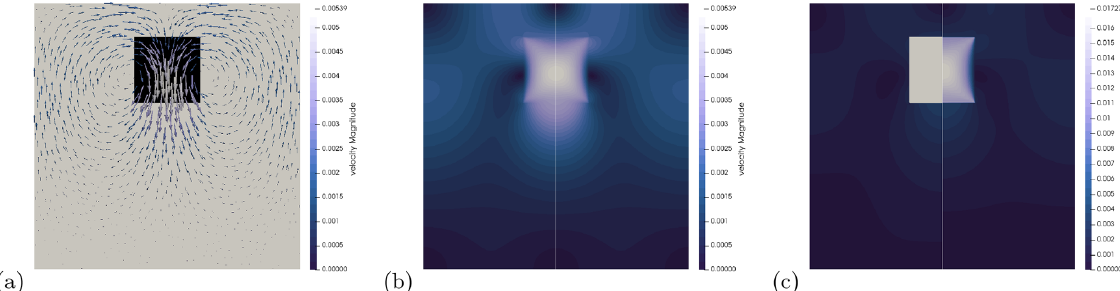
Figure 12. Sinking block benchmark with δρ/ρ = 0 . 25% and η (cid:63) = 10 4 on a 256 × 256 element mesh. (a) Viscosity and velocity field. (b) Velocity field obtained with the Q 2 × Q 1 element (left of vertical white line) and Q 2 × P − 1 element (right of vertical line), both using full density; (c) velocity field obtained with stabilized Q 1 × Q 1 with full density (left) and stabilized Q 1 × Q 1 with reduced density (right).